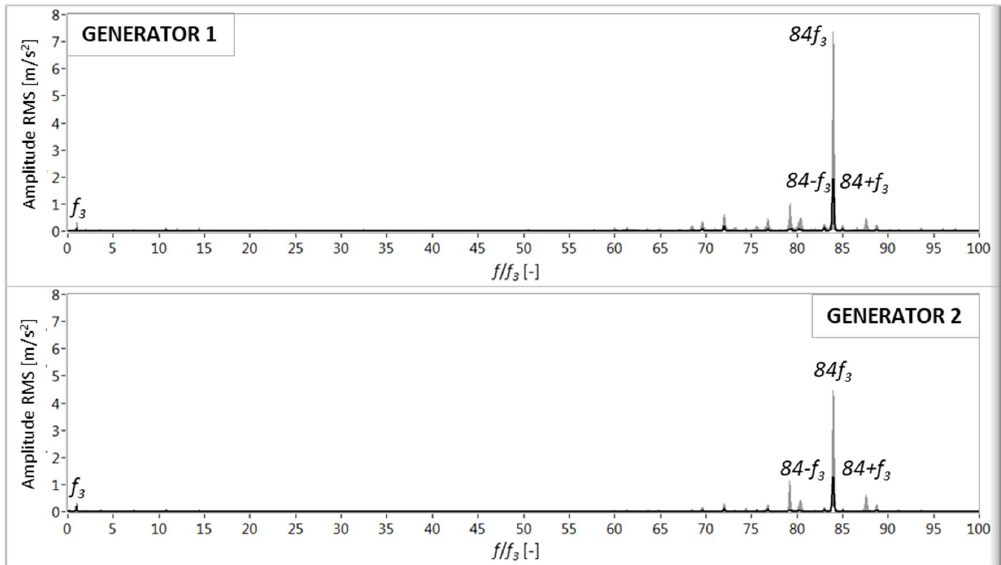
Figure 7. Median spectrum (black line) and amplitude levels between 25th and 75th percentiles (grey region) of the vibrations measured on the generator.